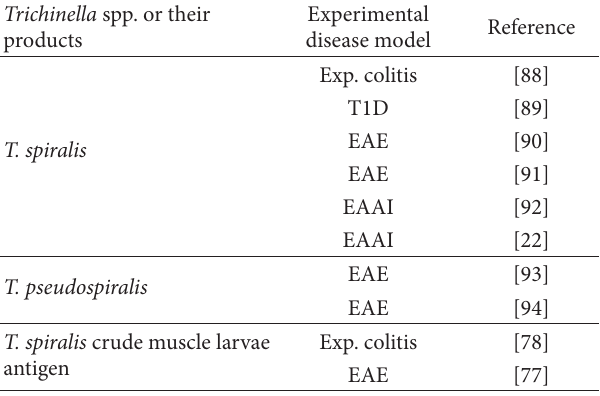
T 3: Experimental models of 2-mediated in�ammatory dis- eases successfully treated by Trichinella infection or administration of Trichinella